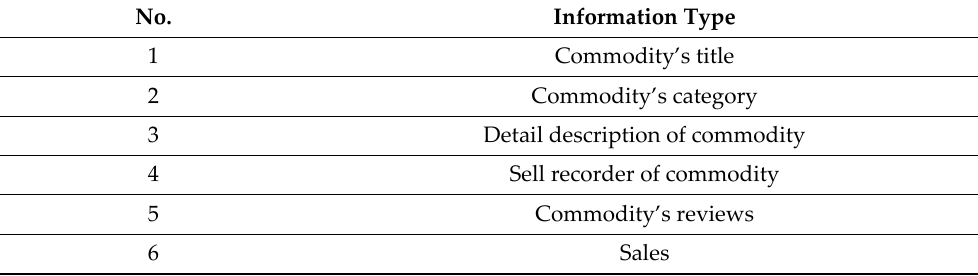
Table 3. Six types of information collected from e‑business platform. Table 2. Four types of information collected from social network platform. No.